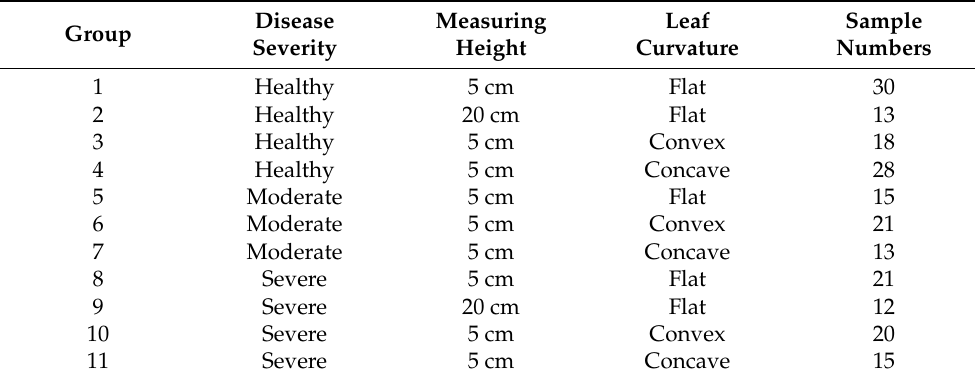
Table 1. Sample numbers under different measuring conditions.